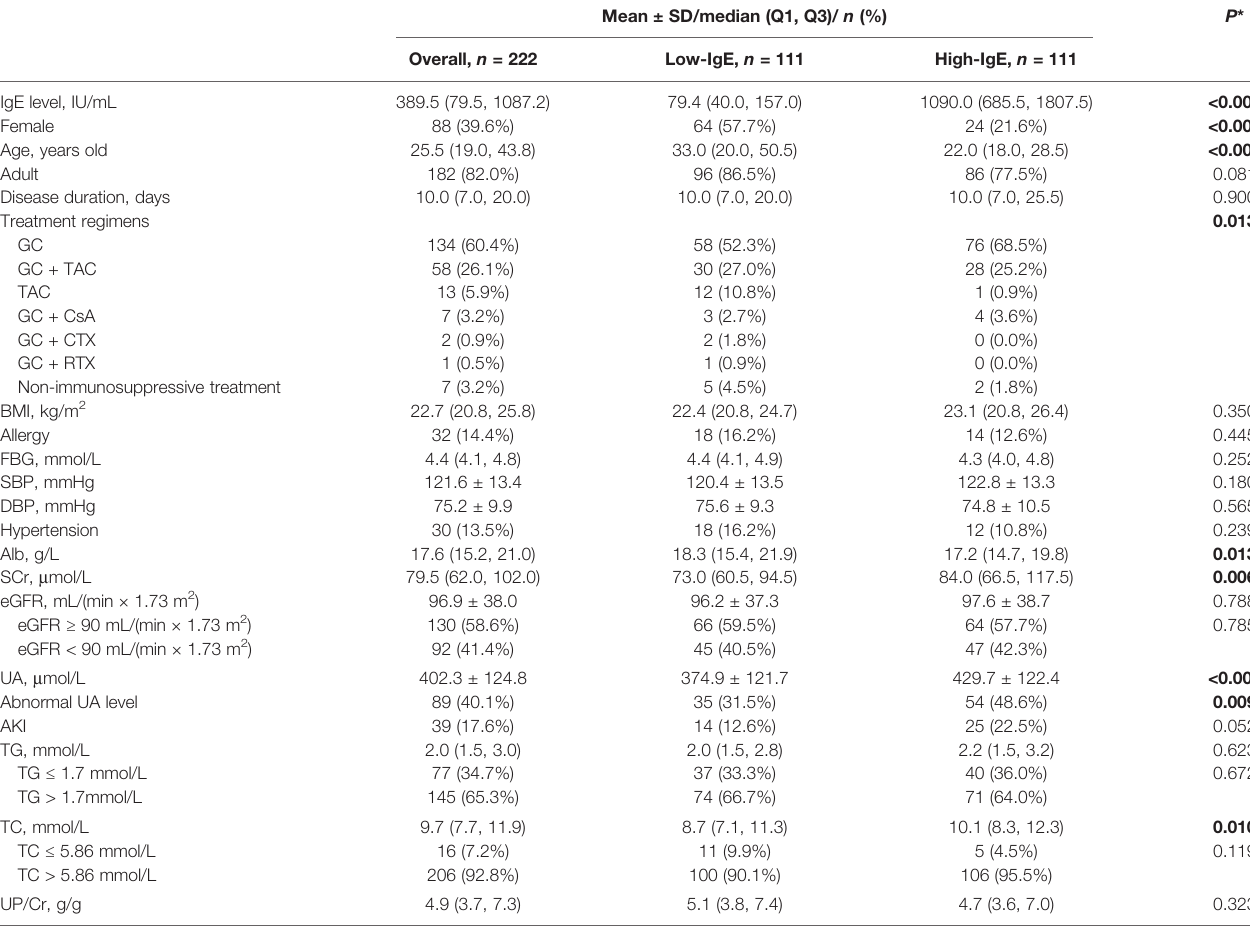
TABLE 1 | Baseline characteristics of patients with minimal change